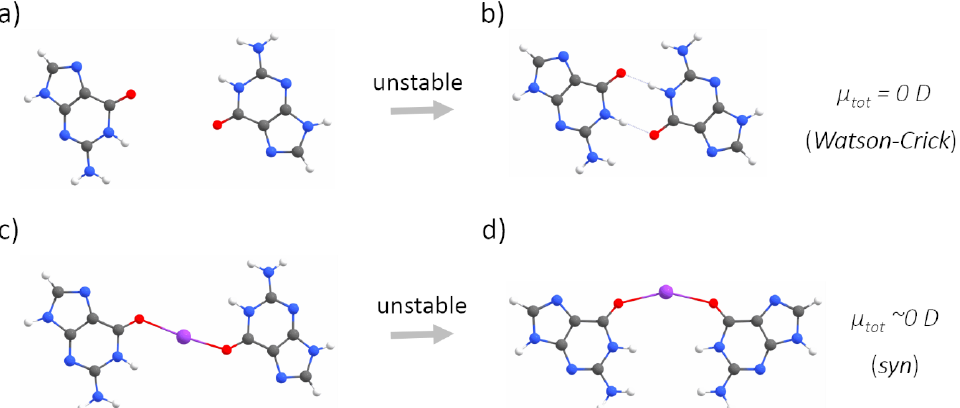
Figure 5. The optimizations of two diagonally opposed guanines without ( a → b ) and with ( c → d ) a metal (here, potassium) cation, calculated at the QM level of theory. The optimizations in both cases were associated with the cancellation of the dipole moments and pronounced changes in the mutual orientation of guanines, that (in both cases) preclude the formation of GQ